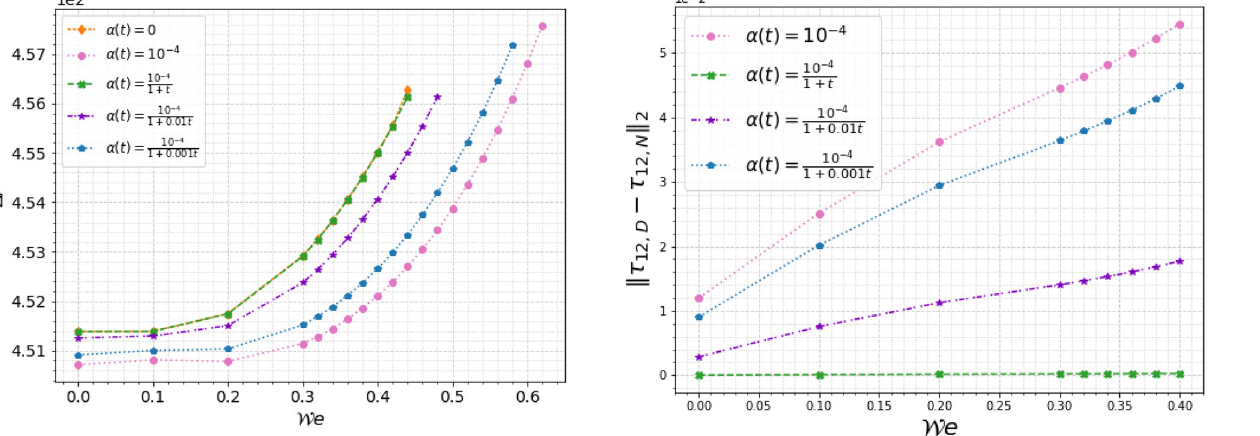
Table 1 The shear stress differences diffusive and non-diffusive model, depending on W e for various parameters 𝜀 in the artificial diffusion coefficient 𝛼 ( t